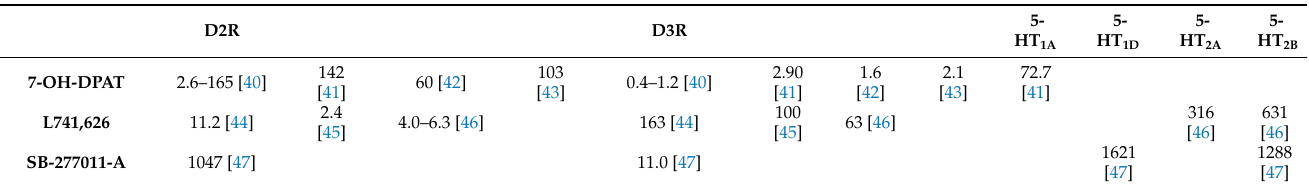
Table 1. Reported affinity (Ki, nM) of 7-OH-DPAT, SB-277011-A, and L741,626 for D2R, D3R, and 5-HT receptors; in square brackets the